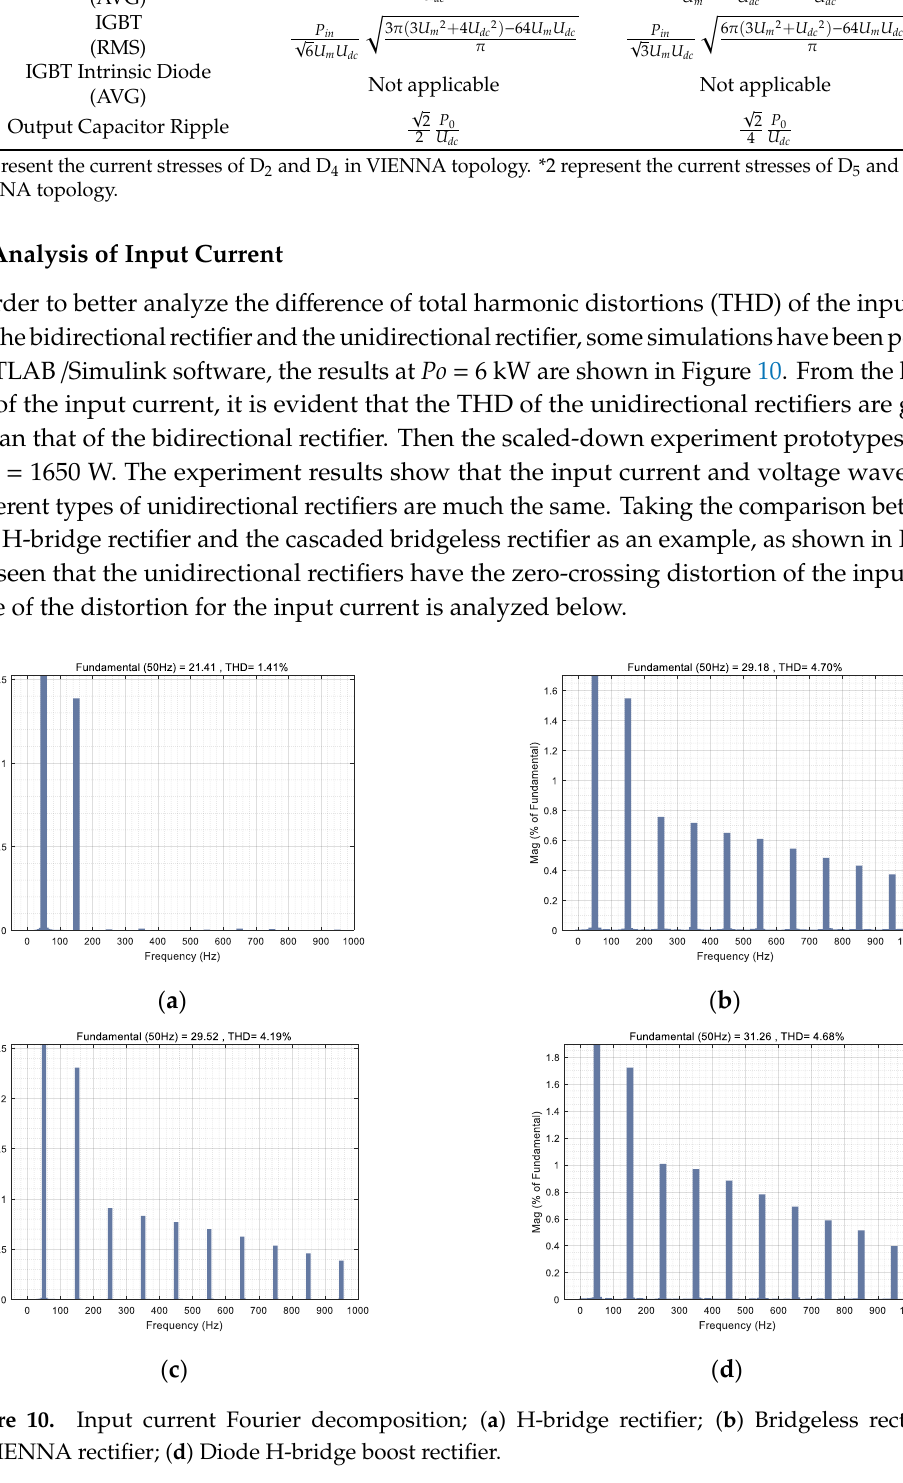
( b ) Figure 11. Input current and input voltage waveforms ( a ) cascaded three-phase H-bridge rectifier; ( b ) cascaded three-phase bridgeless rectifier. Figure 12 shows the AC side phasor diagram under unity power factor for the unidirectional rectifiers. The input voltage u s is in phase with input voltage i s , the voltage across the inductance u L is orthogonal to i s . According to the vector addition, the AC side reference voltage u* con lags the i s by θ . Therefore, the u* con needs to be opposite to i s during the period of θ as depicted in Figure 13. However, due to the unidirectional power flow, the polarity of input current i s should be the identical to the AC voltage u con , so u con can only generate a zero AC voltage during the period of θ . After u* con changes from negative to positive, i s can follow i* s after a period of 𝛾 [12,27]. The distortions of the input current will become more severe while the leading or lagging angle is increased, so the controllability angle for unidirectional rectifier is limited. U s U con ** Figure 12. AC side phasor diagram of unidirectional rectifier.